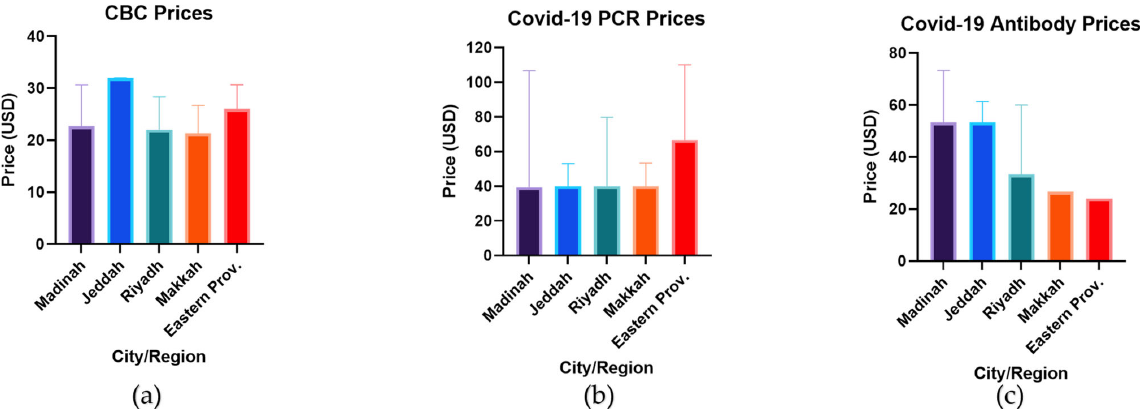
Figure 3. A comparison between the investigation prices based on the location of the medical establishment. The bar charts represent the prices of ( a ) CBC in Madinah (dark purple), Jeddah (blue), Riyadh (green), Makkah (orange), and the Eastern Province (red), and ( b ) the prices of COVID ‐ 19 PCR tests and ( c ) anti ‐ COVID ‐ 19 antibody titers across the different cities. The data demonstrate median values and IQR. USD: United States dollars.